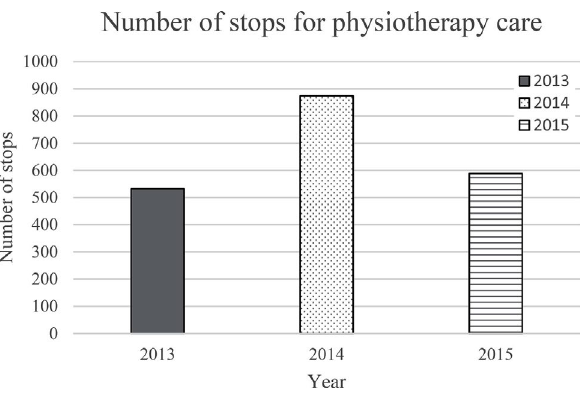
Figure 1 - Number of stops for physical therapy care in 2013, 2014 and 2015 Ultramarathon Rio 24 h